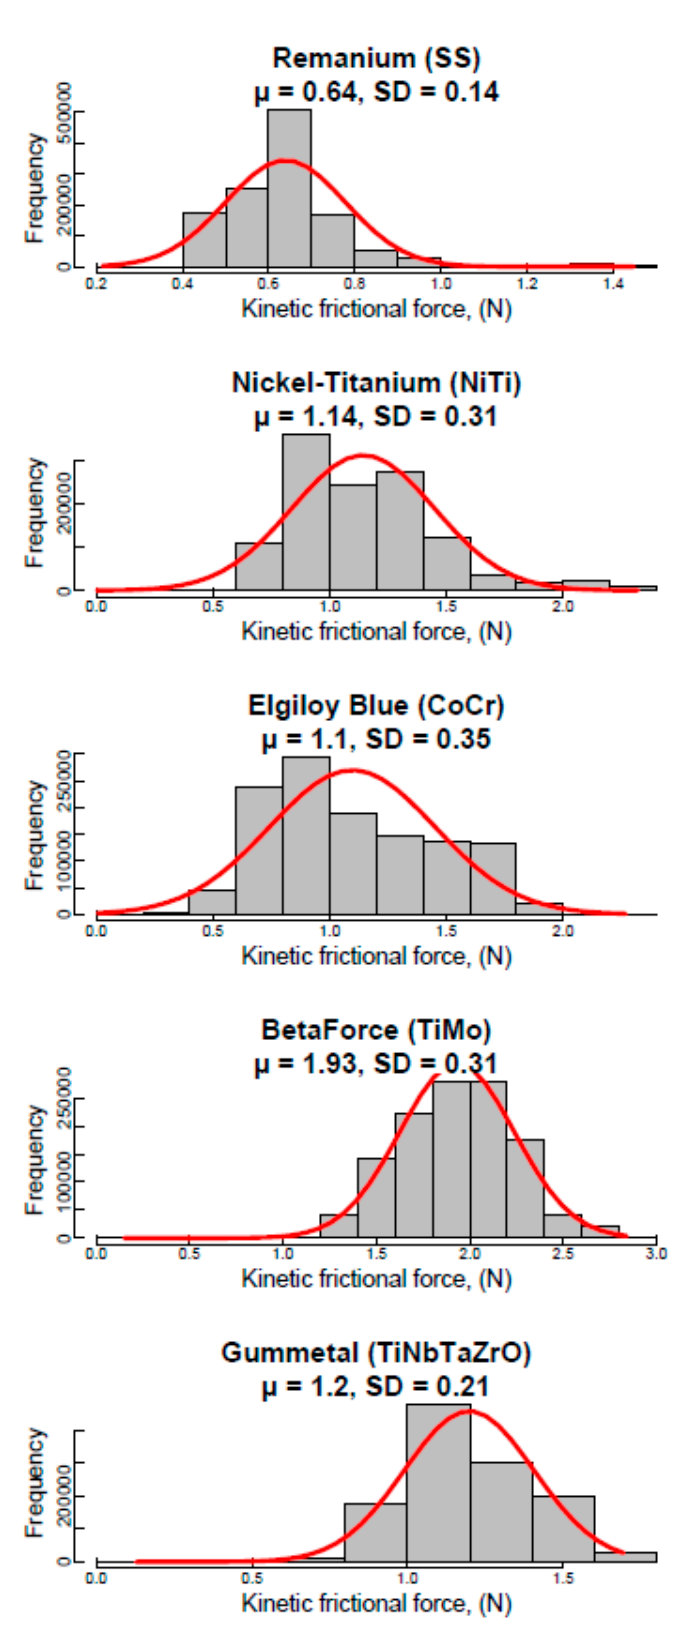
Figure 3. Histogram with normal curve per group of samples ( n = 1,200,000) presenting the empirical distribution of kinetic FF (unit; N).